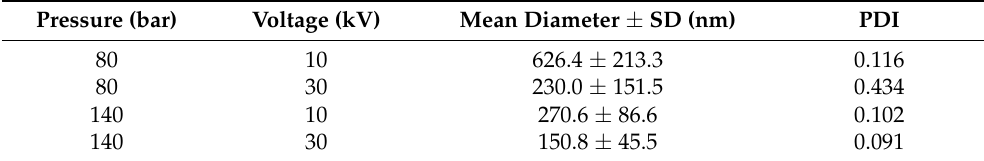
Figure 6. PSDs of samples produced by SC-CO 2 assisted electrospray at 3% w / w PLGA and 10 kV (red) and 30 kV (black), when operating at: ( a ) 80 bar and ( b ) 140 bar. Table 2. Particles mean diameter, SD and PDI of samples produced at 3% w / w PLGA, varying the applied voltage (10 and 30 kV) and the operating pressure (80 and 140 bar). Morphology: particles.